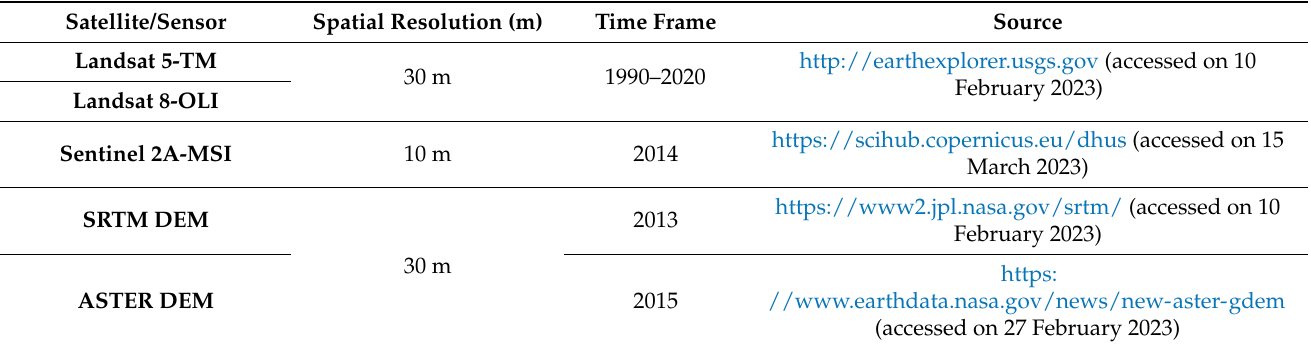
Table 1. Details of the satellite imaginary datasets used for the current